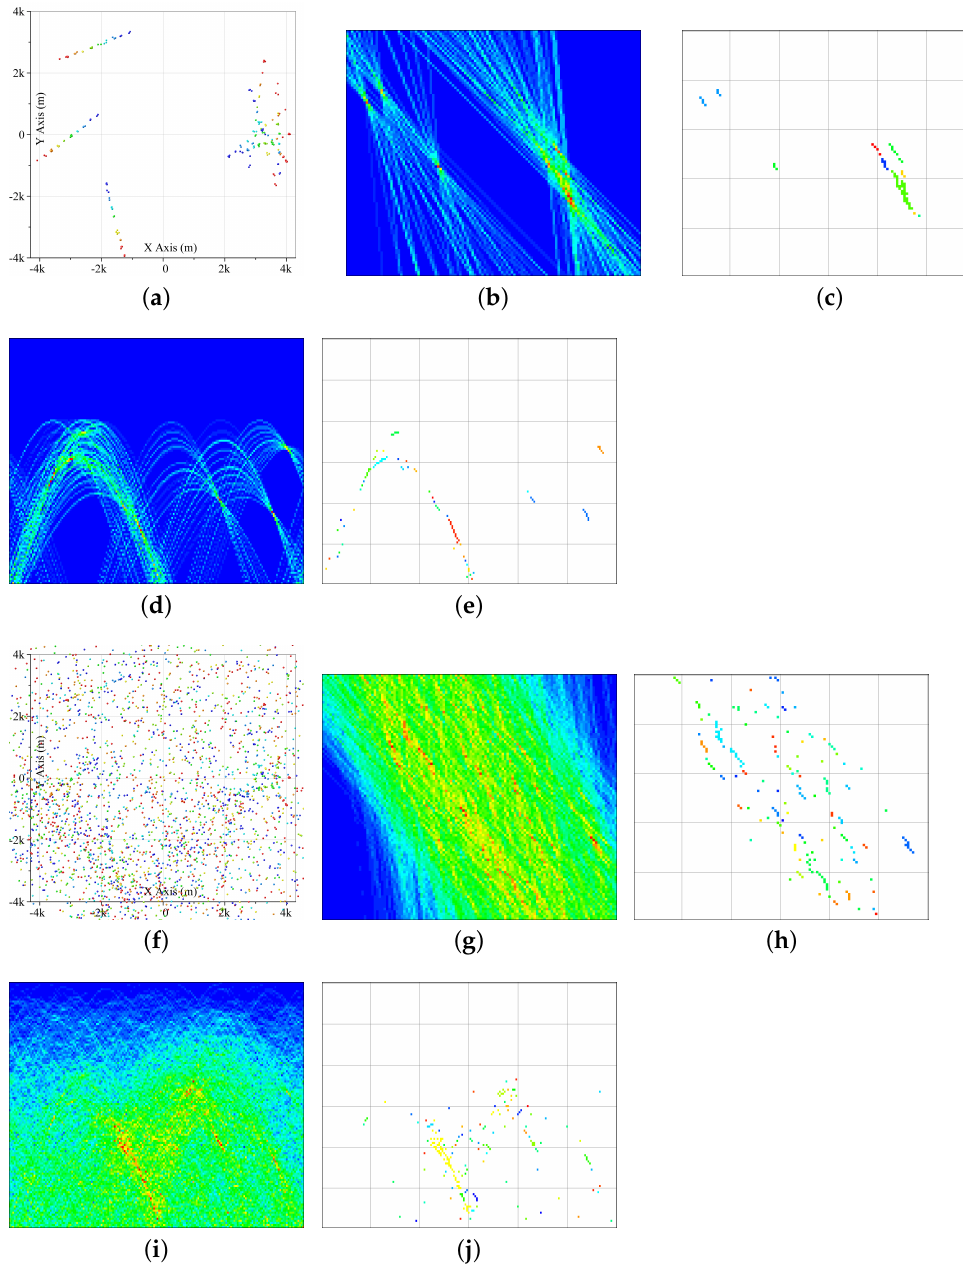
Figure 6. ( a ) Target points in 2D version. ( b ) Parameter map of 2D HT using (45) and only using target points. ( c ) Cluster result of 2D HT parameter map using (45). ( d ) Parameter map of 2D HT using (46) and only using target points. ( e ) Cluster result of 2D HT parameter map using (46). ( f ) All measurement points in 2D version. ( g ) Parameter map of 2D HT using (45) and using all measurements. ( h ) Cluster result of 2D HT parameter map using (45). ( i ) Parameter map of 2D HT using (46) and using all measurements. ( j ) Cluster result of 2DHT parameter map using